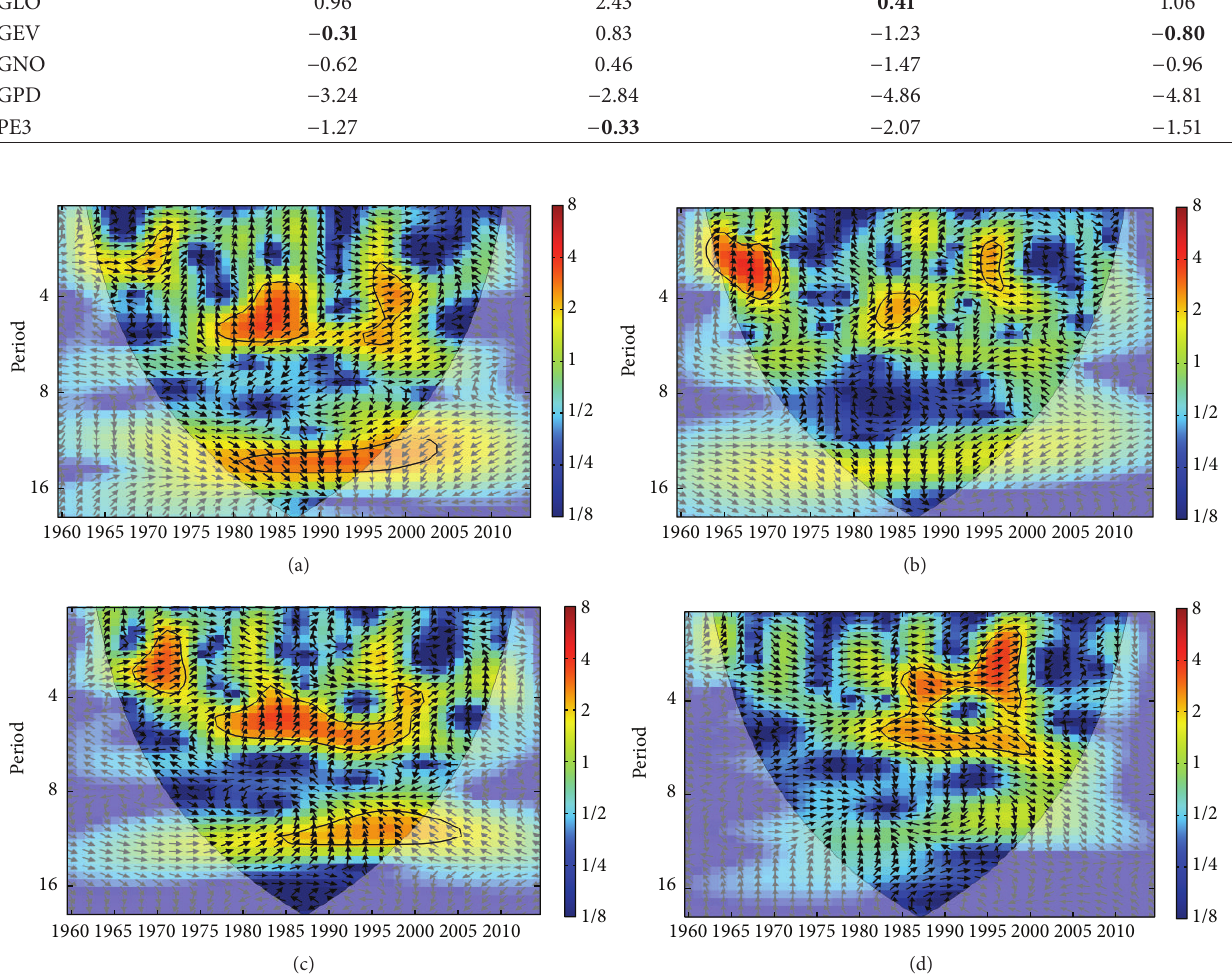
Figure 10: The cross wavelet transforms between the ENSO events and AMDSL series in stations Huajianlin (a), Huanxian (b), Changwu (c), and Huaxian (d). The meanings of the symbol can be referred to Torrence and Compo